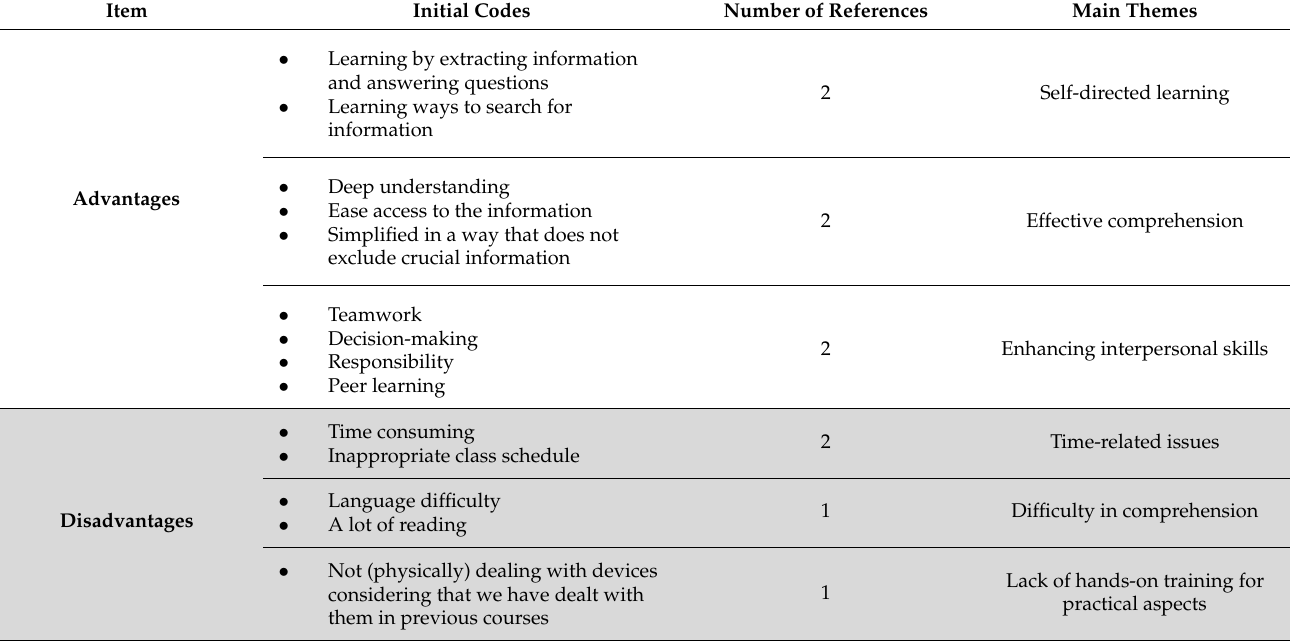
Table 6. Advantages and Disadvantages of paper-based in class group learning (PICkLE) from students’ point of